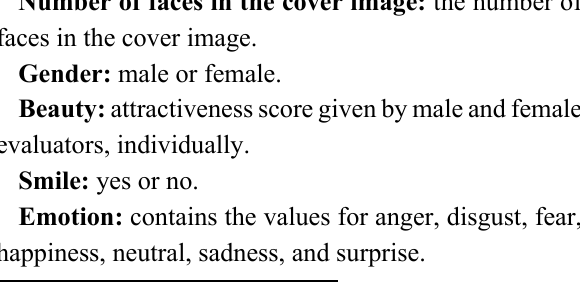
Fig. 2 Histogram of the goal amount. §